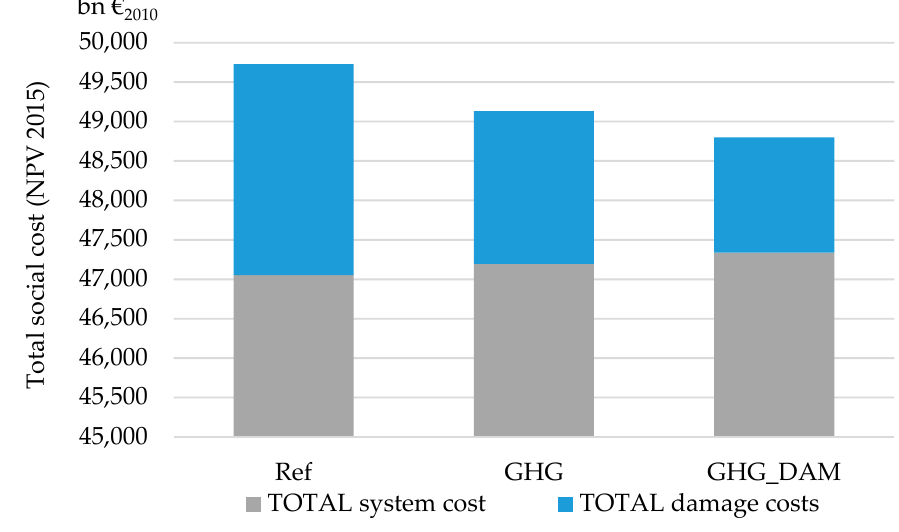
Figure 5. Total social cost in the EU28 (bn €, 2010).